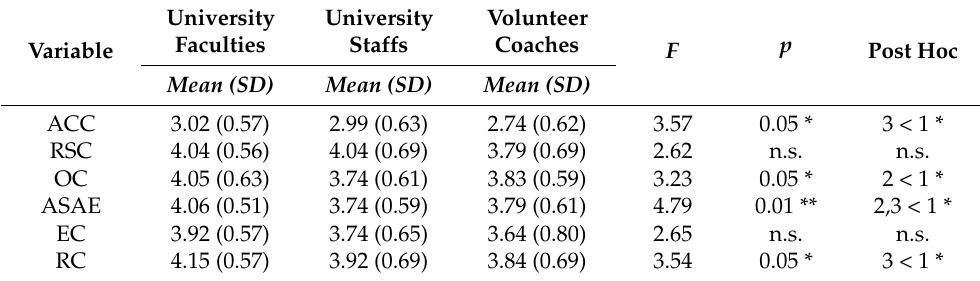
Table 5. Relationship between the employment status of coaches and their possession scores.